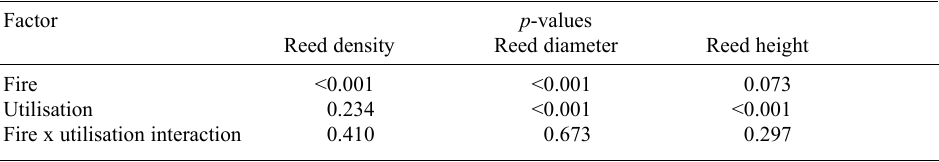
Results of factorial analyses of variance (ANOVAs) examining the effects of fire and harvesting on reed den- sity, reed diameter and reed height in the Muzi Swamp, Tembe Elephant